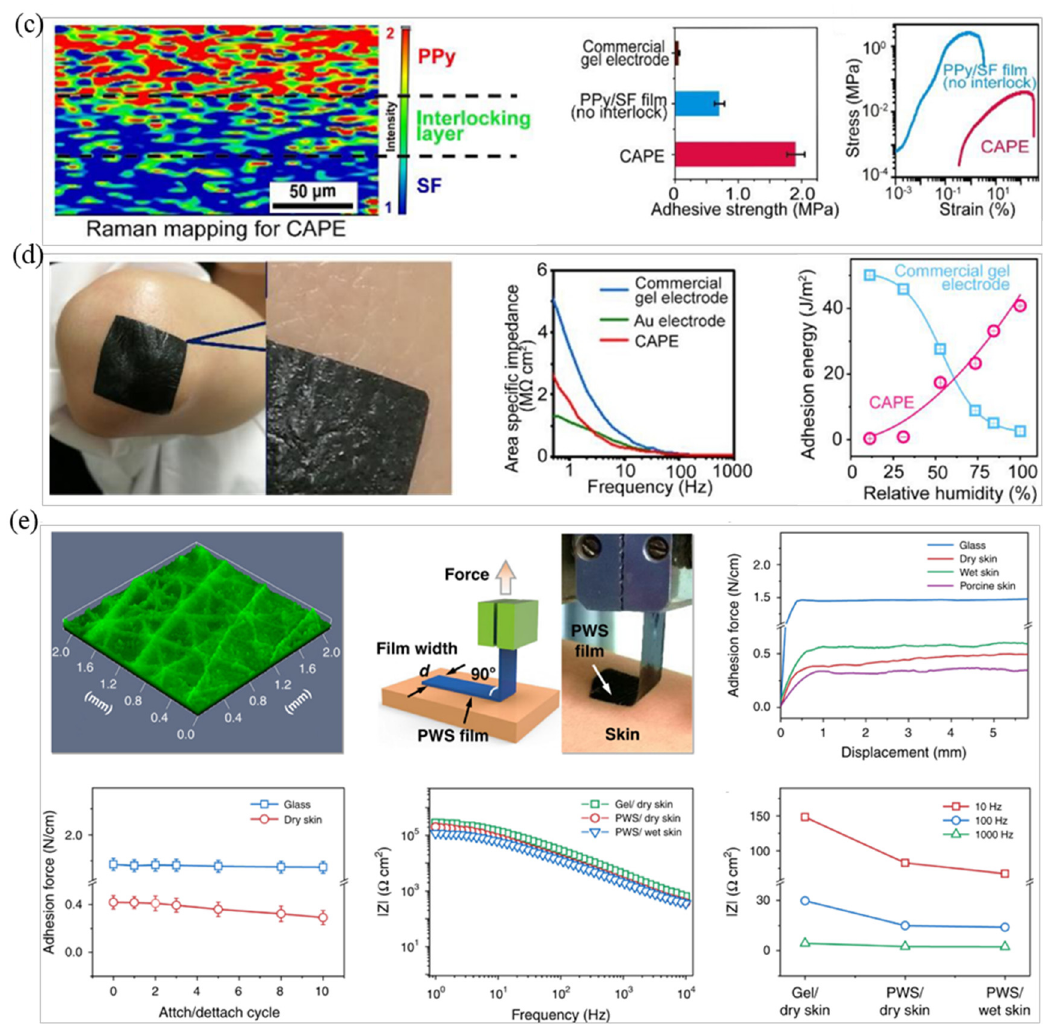
Figure 4. A summary of preparation strategies for high-adhesive electrical physiology electrodes based on intrinsic adhesive material. ( a ) Schematic diagram of the fabrication of a Ag nanowire (AgNW)/silk electrode; schematics and photos of conformal attachment of the AgNW/silk electrode. Reproduced with permission from [113]. Copyright 2018, American Chemical Society. ( b ) Photographs showing a four-leaf clover e-tattoo attached to the forearm and the relative resistance changes as a function of applied tensile strain. Reproduced with permission from [116]. Copyright 2019, John Wiley and Sons. ( c ) Raman mapping for the section of CAPE showing the three-dimensional network structure of PPy and the interlocking structure between PPy and the silk fibroin (SF) gel layer; adhesive strength between the conductive and adhesive layer of CAPE was higher than that of commercial gel electrodes; maximum strain of CAPE was 300%, which was much higher than the 1% for a PPy/SF film fabricated by pasting. ( d ) Highly conformal property of CAPE on a human elbow; CAPE had a lower electrical impedance in the frequency range of 3 to 100 Hz compared with commercial gel and Au/SF electrodes; interfacial adhesion energy of CAPE increased with increasing RH, from 11% to 94.6%, compared with commercial gel electrodes. ( c , d ) are reproduced with permission from [109]. Copyright 2020, American Chemical Society. ( e ) Cross-section SEM image of a PWS film conformed on rough skin; setup for the measurement of interfacial adhesion on skin or glass by the standard 90-degree peel test; interfacial adhesion forces of PWS films on glass and various skins; adhesion forces of PWS films on glass and dry skin within ten repetitions of attaching/detaching; impedance spectra of commercial Ag/AgCl gel and PWS dry electrodes on dry and wet skin, and the corresponding impedances at 10, 100, and 1000 Hz. Reproduced with permission from [18]. Copyright 2020, The